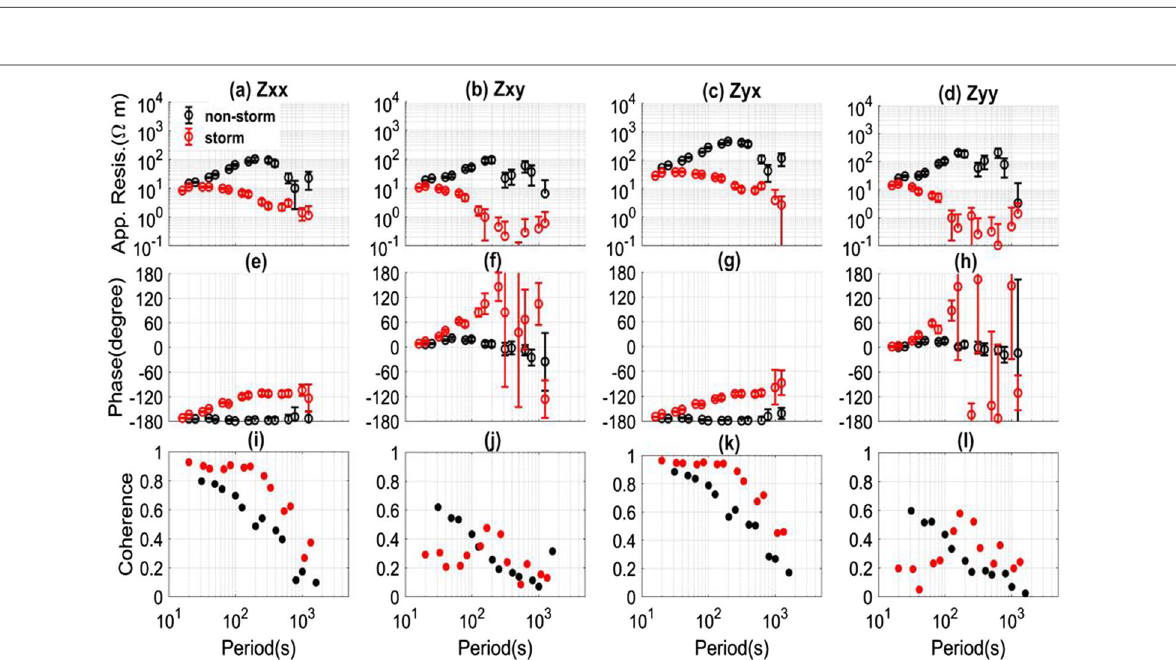
Fig. 11 MT sounding curves and coherence distributions during the storm and non-storm days using the data observed at site 130. The black color indicates the results calculated by the non-storm data observed from 00:00 on October 26 to 00:00 on October 29; the red color indicates the results calculated by storm data observed from 06:00 on October 29 to 06:00 on October